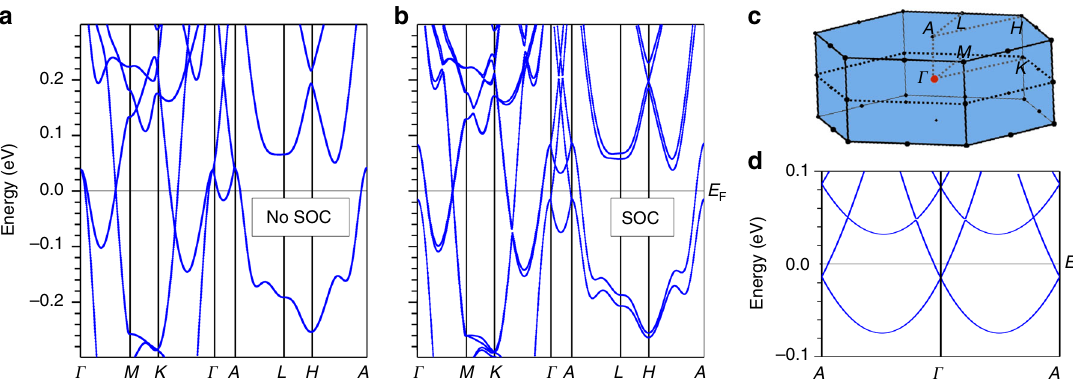
Fig. 4 Electronic band structure of CoNb 3 S 6 . a Without inclusion of spin – orbit coupling and b with inclusion of spin – orbit coupling. Spin – orbit coupling causes splitting of the bands, which is most pronounced along Γ − A . c Brillouin zone of CoNb 3 S 6 . d Electronic band structure (with SOC) near the Fermi energy along the A – Γ – A high